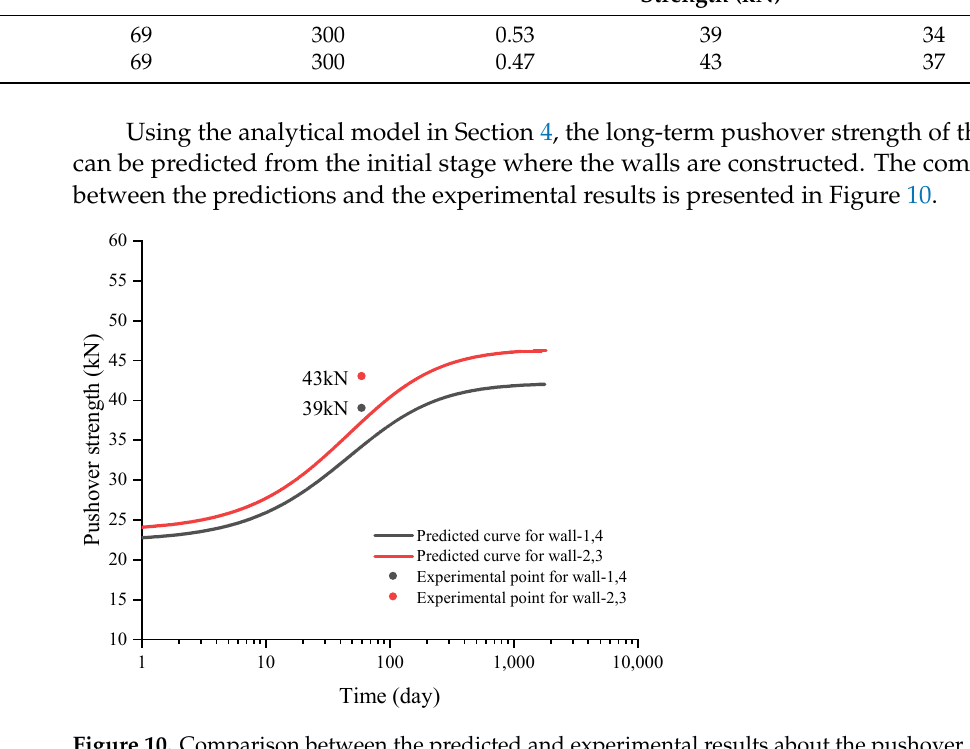
Figure 10. Comparison between the predicted and experimental results about the pushover strength. In addition, to better understand the thermo-hydro-mechanical (THM) behaviors of the unstabilized rammed earth (URE) wall with the changing of time, the variations of the average RSI value and hydraulic conductivity of the wall are also predicted, and the results are presented in Figure 11a,b.